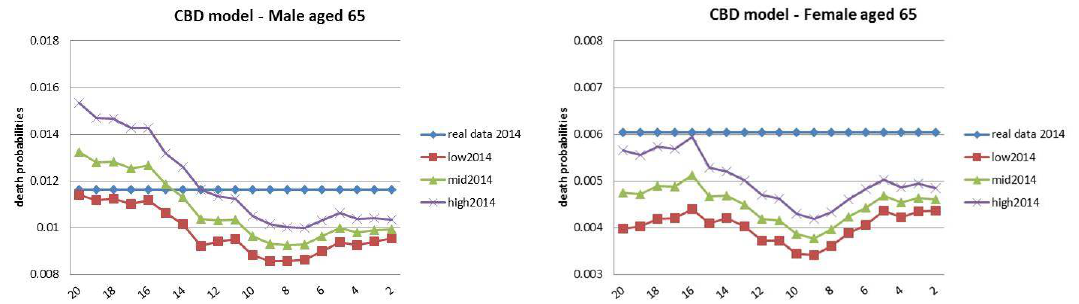
Figure 17. CBD Rolling Fixed-Length Horizon Backtests (age 65): convergence to real data